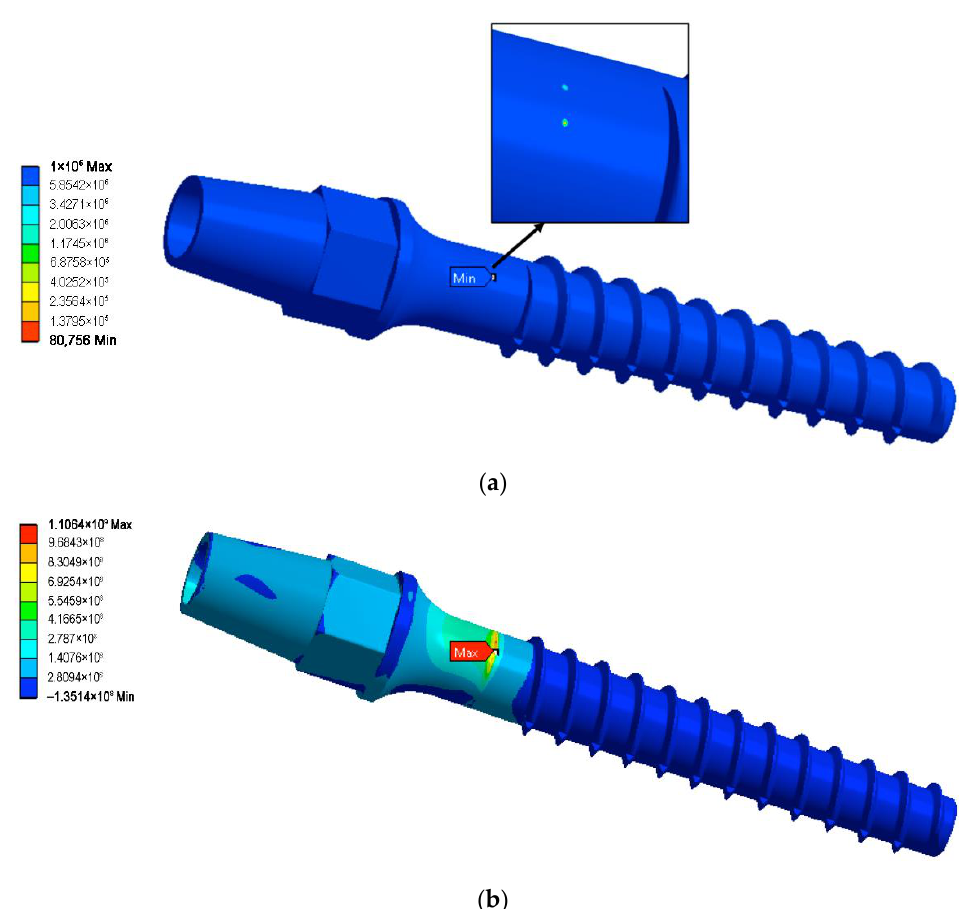
Figure 7. Life prediction for the 1.9 mm UFG Ti model and force application angle of 32° ( a ) and maximal principal stress 𝜎 1𝑚𝑎𝑥 distribution in the static load test for the 1.8 mm model ( b ). Table 2. Results of virtual fatigue tests.